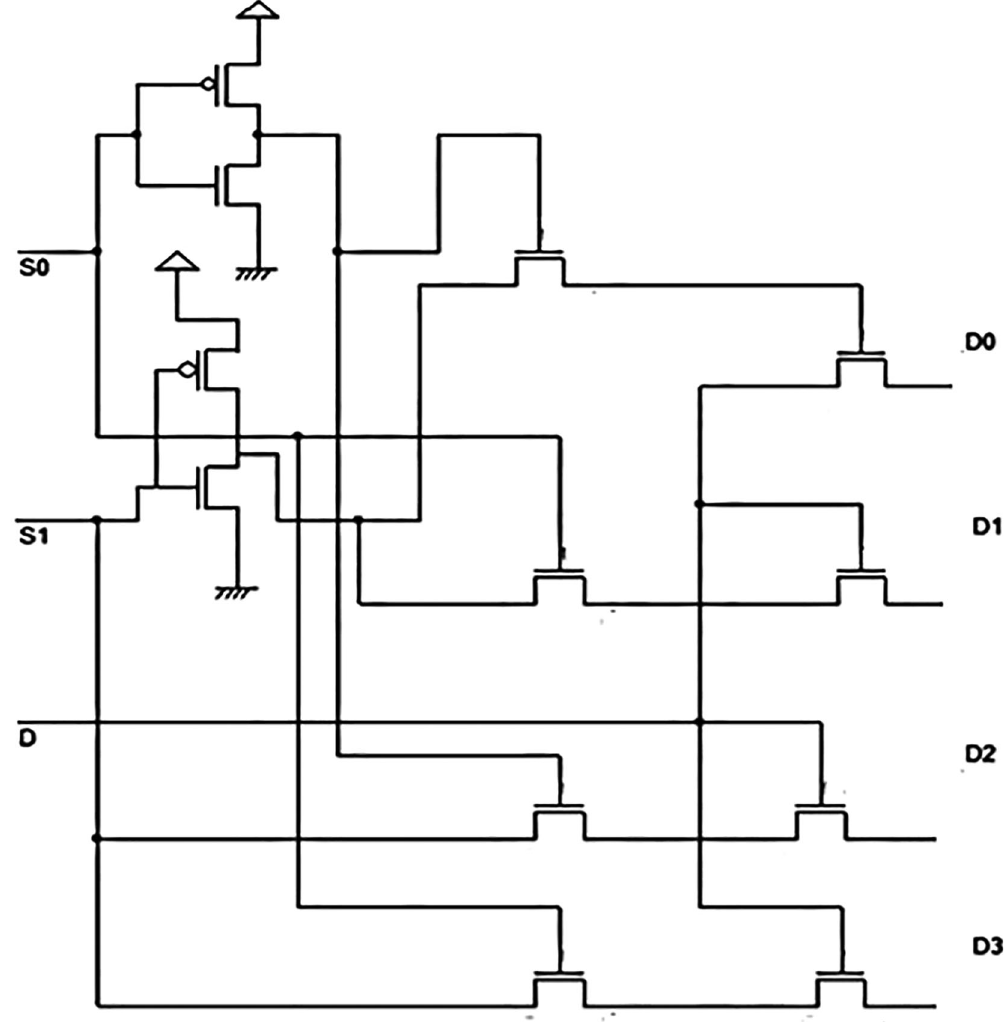
Figure 2. Proposed circuit of the 1 (cid:1) 4